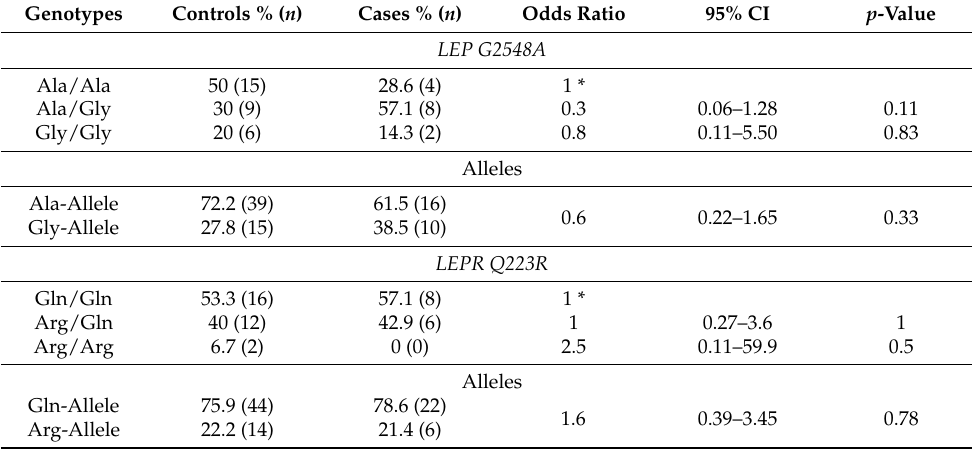
Table 6. Results of G2548A LEP and Q223A LEPR of controls and Group 1 cases with BMI > 29.9 (Overweight to Morbidly Obese) and no abnormal sleeping, eating, and stress parameters.